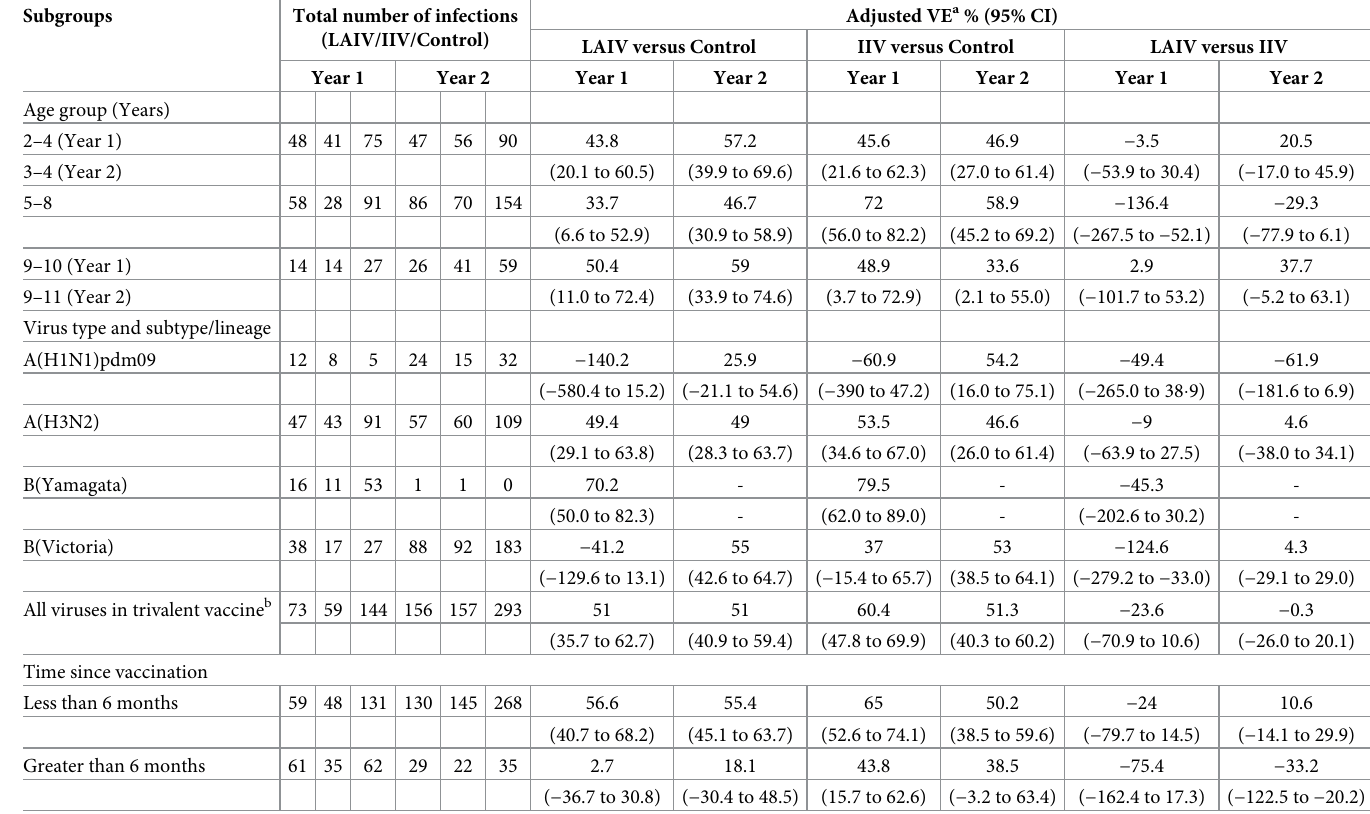
a Estimated using Cox proportional hazards model, with household-level random effect.